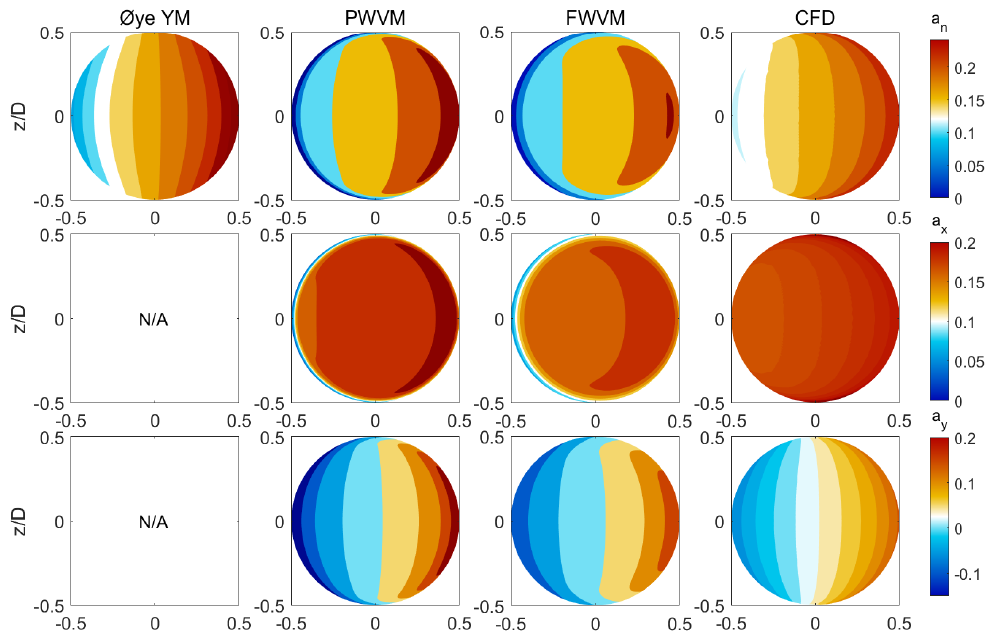
Figure 4. Induction field at the actuator disc on the axis normal to disc, x axis and y axis from different models when yaw angle = 30 deg and C T = 0.6.